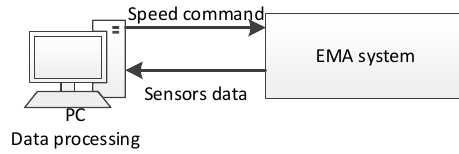
Figure 4. Schematic diagram of test bench.